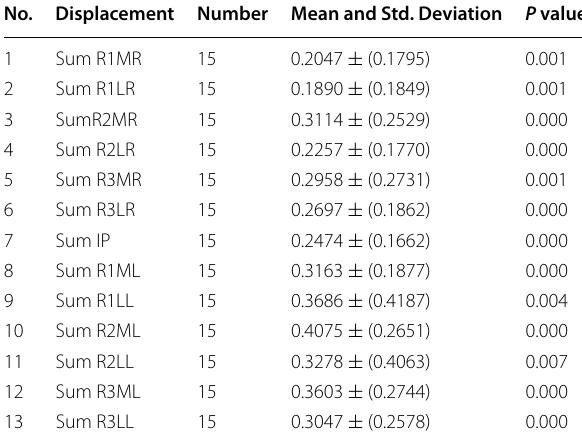
Table 3 One-sample statistics, comparison in coordination changes of rugae in pre- and post-treatment in expansion group–right rugae (1–6); and left rugae and incisive papilla (7–13) No. Displacement Number Mean and Std. Deviation P